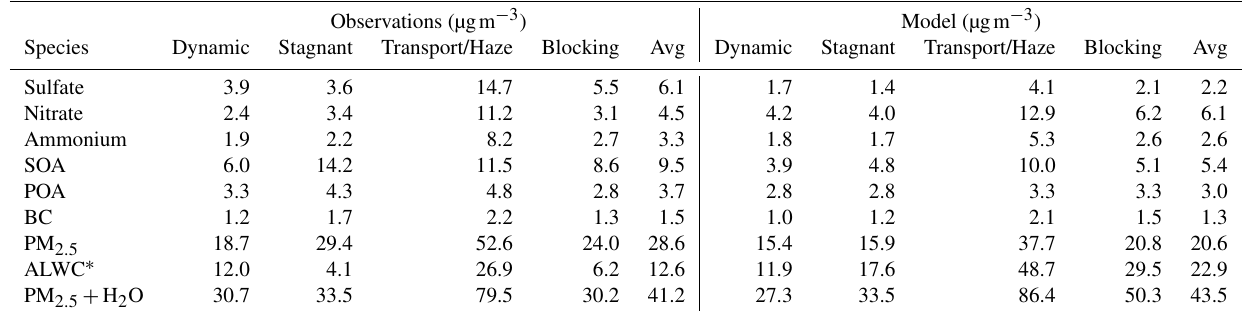
Table 3. Modeled vs. observed PM 2 . 5 composition.